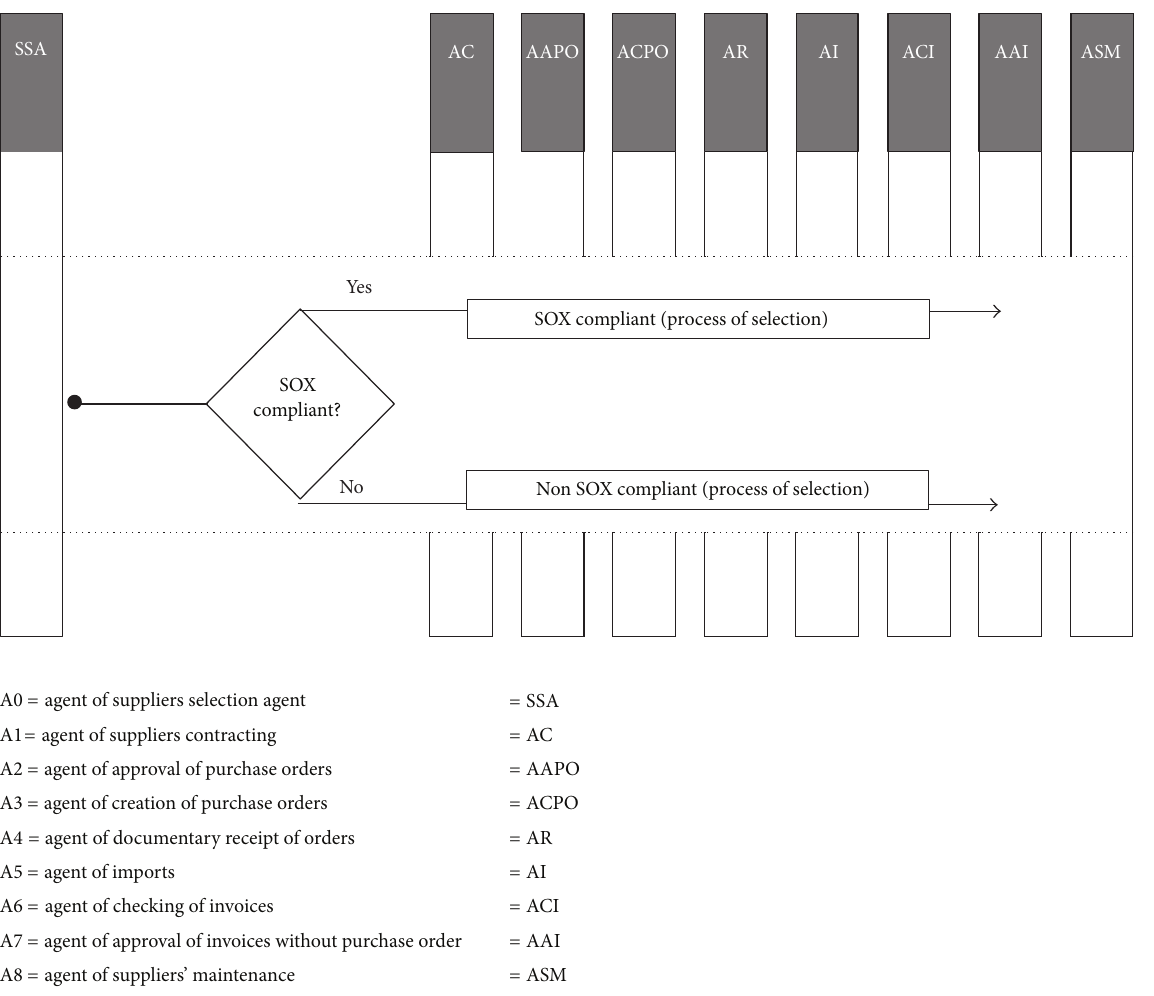
Figure 5: Mutual Shared Communication